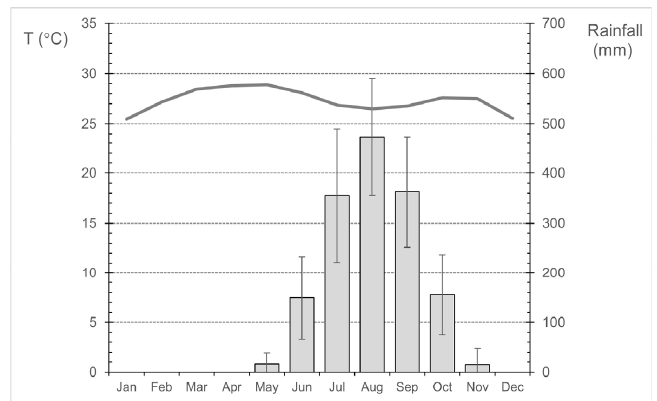
Figure 2. Mean monthly precipitation (columns, with error bars based on standard deviation) and mean monthly temperature (line) in Bissau/Observatory station, over the period 1981–2010. Data source: National Institute of Meteorology of Guinea ‐ Bissau.